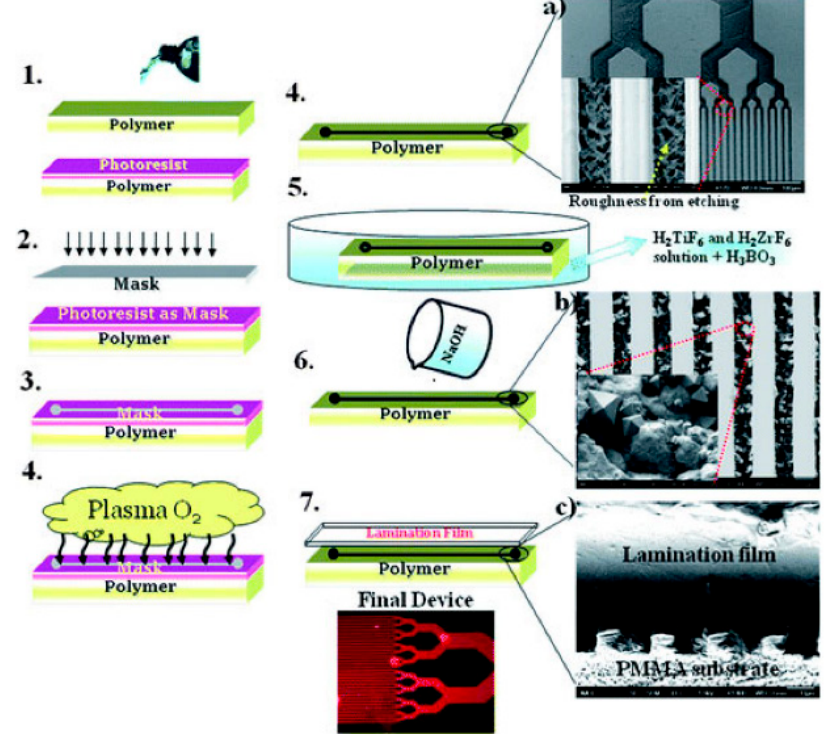
Figure 2. Schematic representation of liquid deposition method for preparing TiO 2 –ZrO 2- based mi- crofluidics for phosphopeptide enrichment. 1. Photoresist layer coating on polymethyl methacrylate (PMMA) substrate; 2, 3. Lithography and development of photoresist layer. 4. Plasma etching of PMMA substrate. 5. Liquid deposition of H 2 TiF 6 and H 2 ZrF 6 solution. 6. Rinsing with NaOH and water. 7. Device sealing with lamination film. Reprinted with permission from Tsougeni et al. [20]. Copyright 2011 Royal Society of Chemistry, 2011.